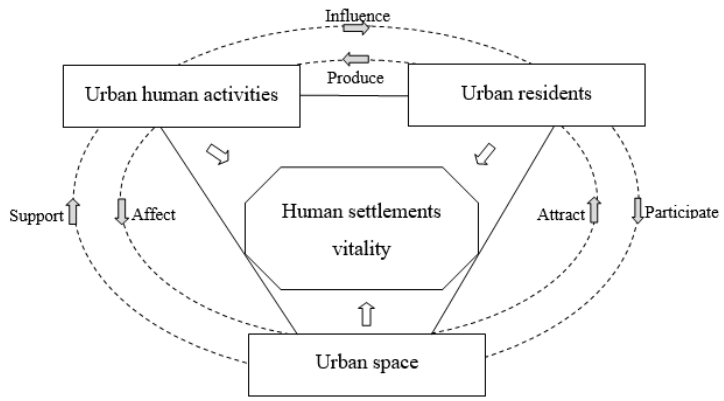
Figure 1. The three elements of urban human settlements vitality.